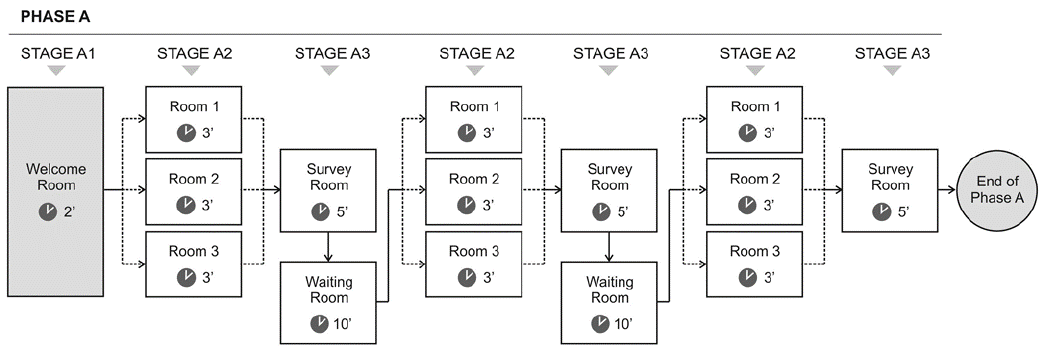
Figure 3. Flowchart for the experiment, showing all the stages in Phase A.